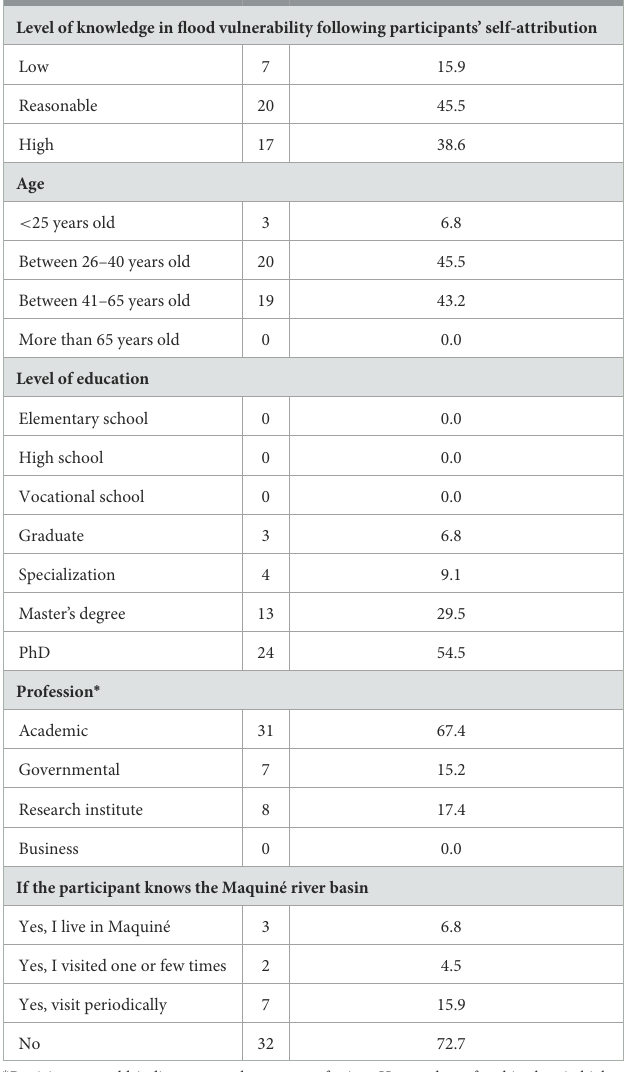
TABLE 1 Participants’